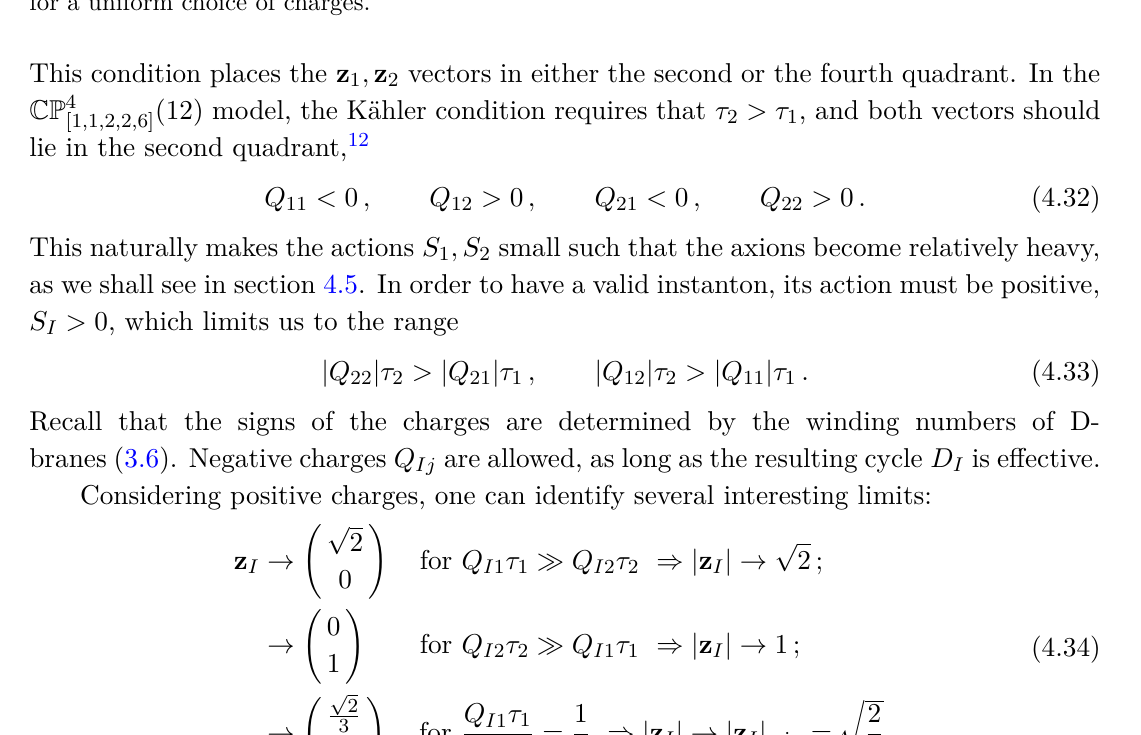
Figure 4 . The convex hull condition (CHC) from the weak gravity conjecture. The convex hull spanned by all the normalized charge vectors z I should include the circle of radius r CHC defined in (3.55). We place the vector z 3 in the first quadrant in order to obtain a large action and hence suppress the corresponding instanton contribution. In order to satisfy the CHC, the original lattice vectors z 1 , z 2 should then lie in the second or fourth quadrant. The solid and dashed convex hulls √ correspond to the cases Q I 2 τ 2 = 2 Q I 1 τ 1 and Q I 2 τ 2 = 2 Q I 1 τ 1 , respectively. Note that all z I vectors for the original instantons lie on the same line. The CHC favors near-isotropic geometry for a uniform choice of